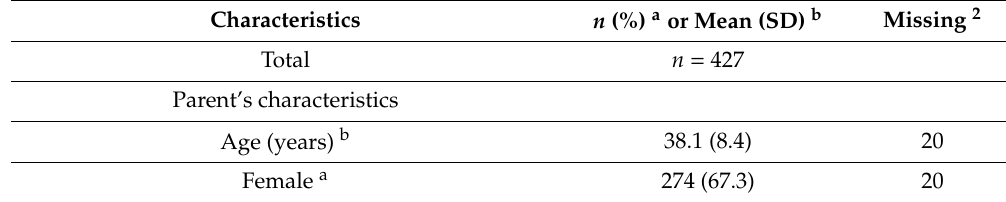
Table 1. Participant and child characteristics 1